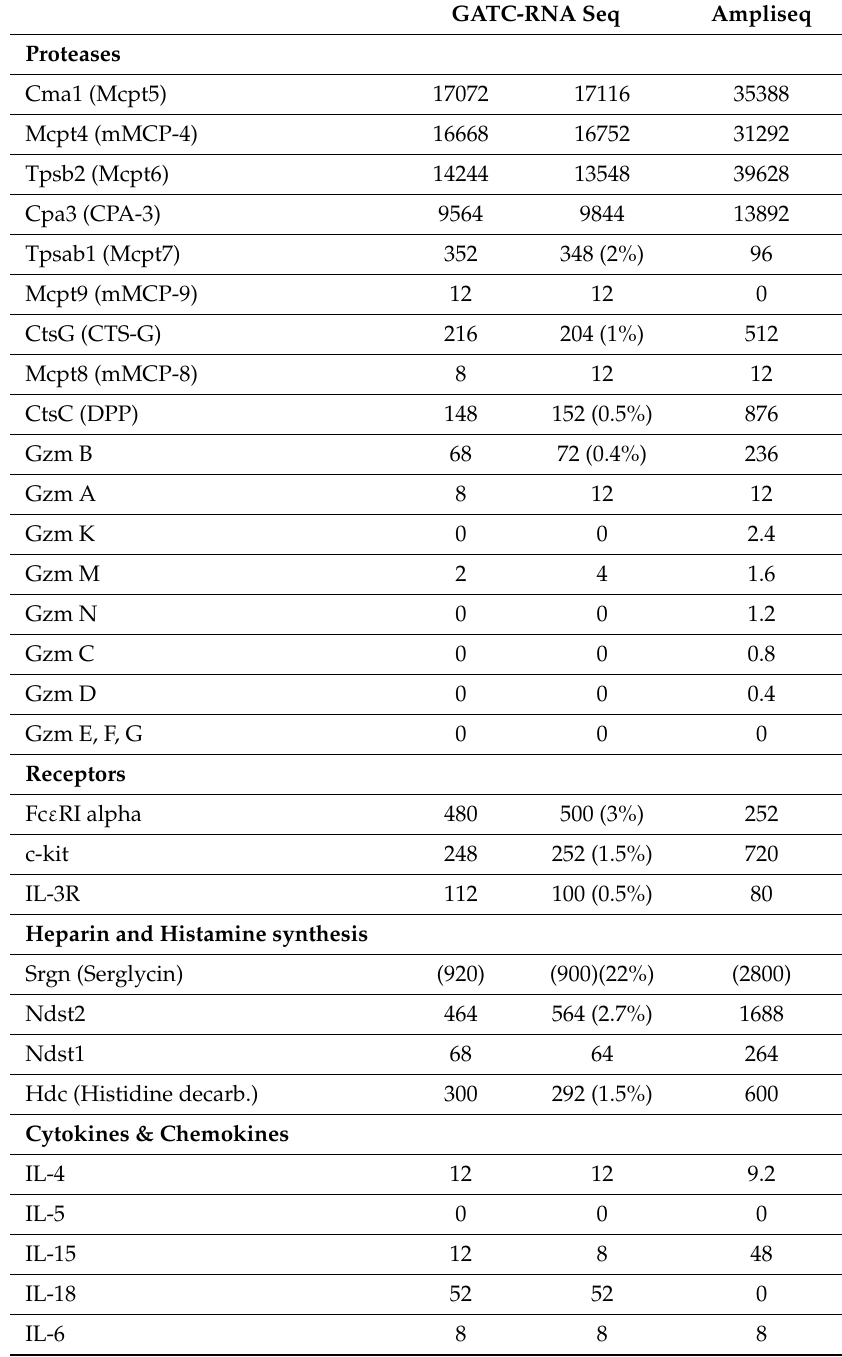
Table 1. Transcript levels for granule proteases, cell surface receptors, and enzymes involved in the production and processing of the granule components in mouse peritoneal MCs from BALB / c mice. The number of normalized reads for the proteases is given in actual numbers (obtained from GATC biotech and SciLife Thermo Fisher Ampliseq analyses). Two independent GATC RNA seq runs were performed. For comparison, the relative levels in % to the most highly expressed transcripts (Mcpt5) are indicated in